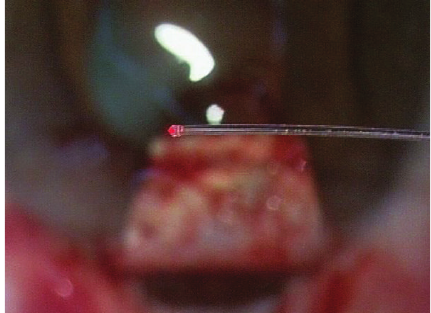
Figure 3: Microcatheter connected to a laser flickering red light source.